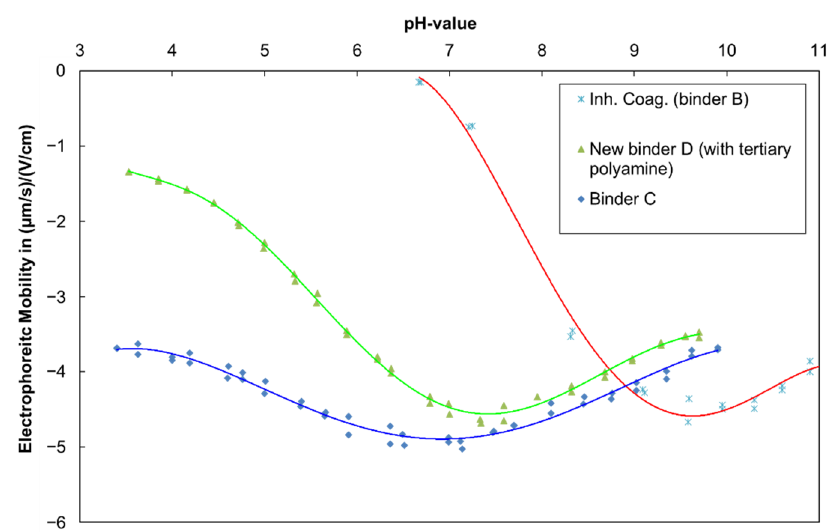
Figure 5. Electrophoretic mobility of the new binder D, binder C (without a tertiary polyamine) and binder B with an inhibited coagulant. The mobility curve for binder A is very similar to binder C.